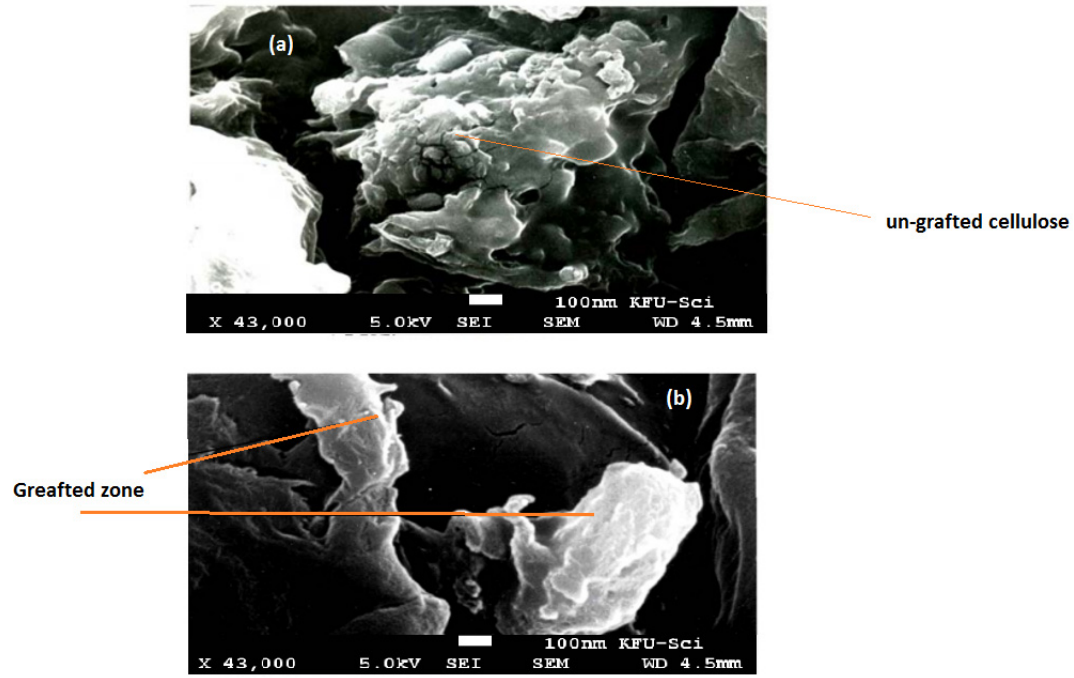
Figure 3. Scanning electron microscopy of native cellulose ( a ), and HEMA/C copolymer ( b ).